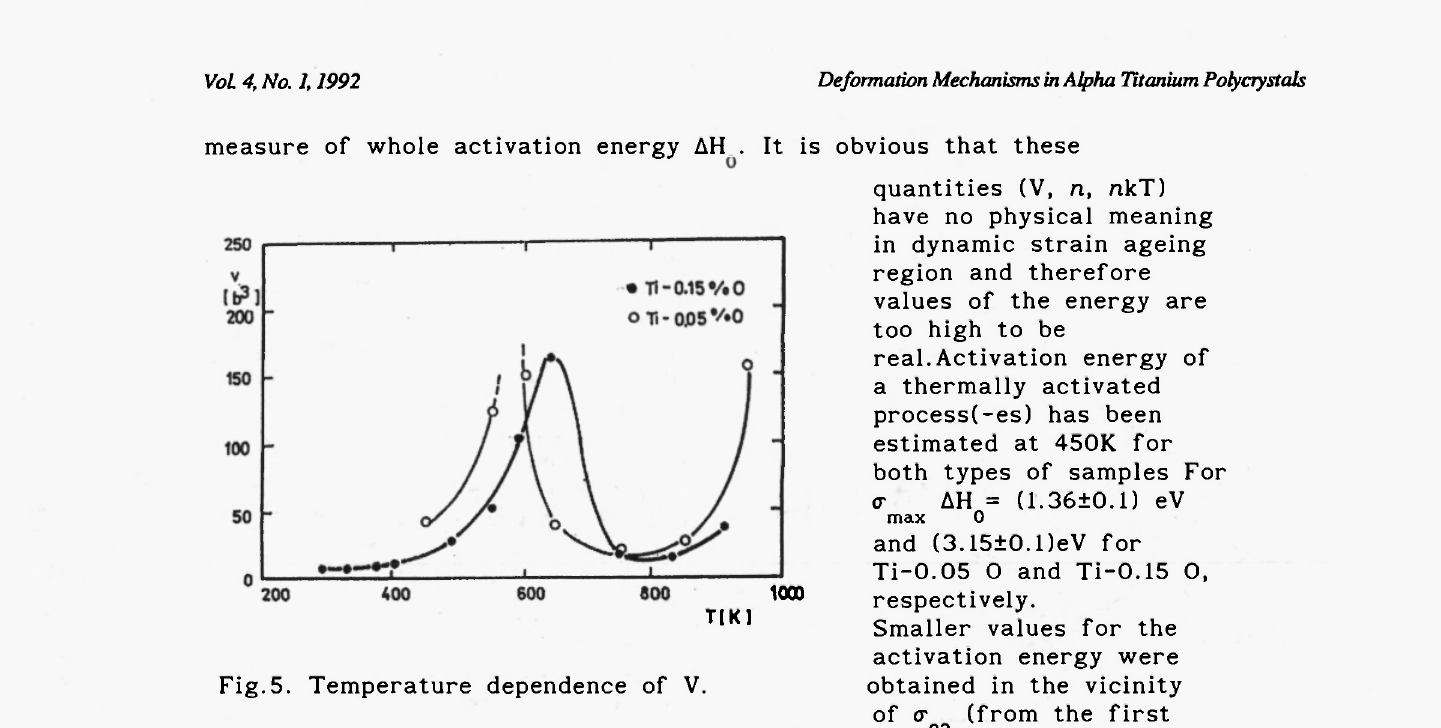
Fig.5. Temperature dependence of